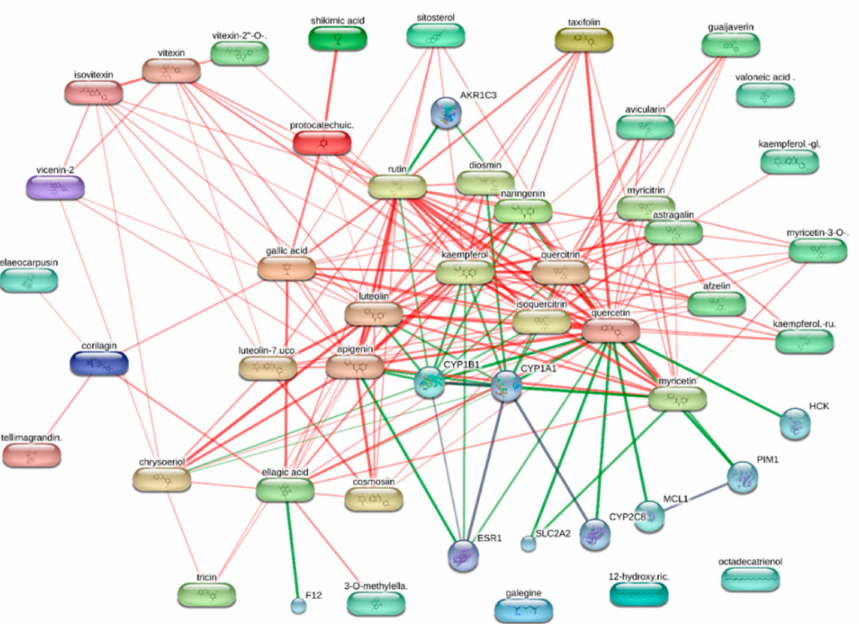
Figure 1. Components-targets analysis conducted on the phytochemicals identified by HPLC- MS in A. cordifolia methanol extract. Single protein targets predicted by STITCH platform (http: //stitch.embl.de/) are shown. Quercetin, kaempferol, and apigenin were predicted to interact with estrogen receptor 1 (ESR1). Quercetin and myricetin showed a putative capacity to interact with pim-oncogene (PIM-1), whereas the sole quercetin was predicted to interact with hemopoietic cel kinase